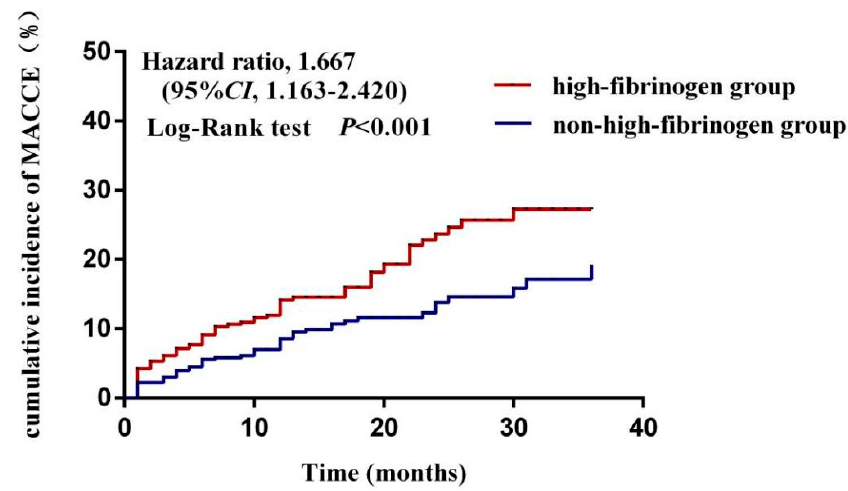
Figure 3. Comparison of the cumulative incidence of MACCE between non-high-fibrinogen group and high-fibrinogen group.